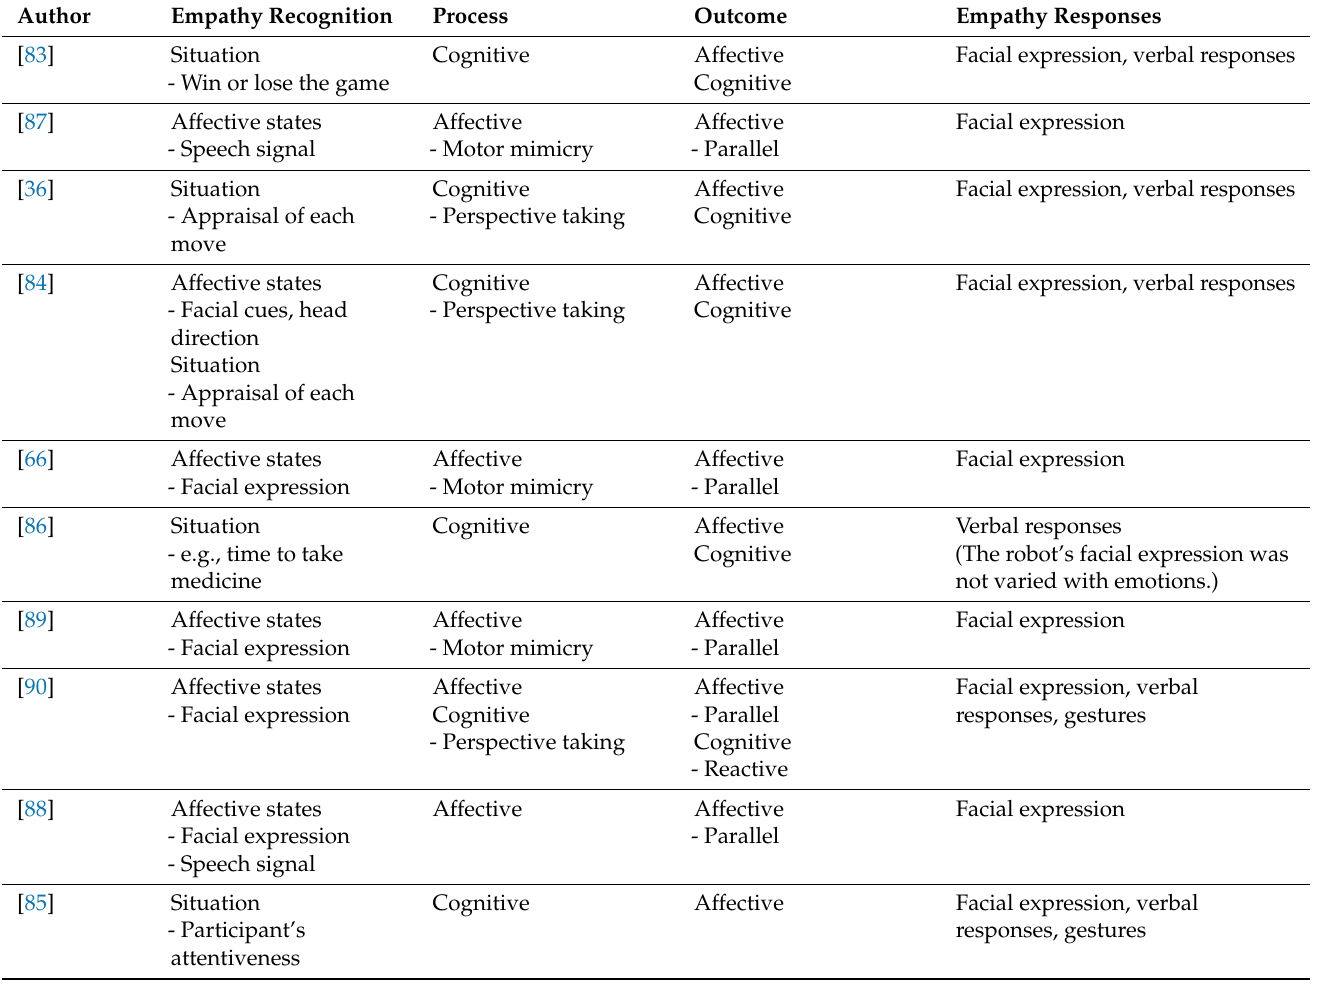
Table 6. Empathic recognition and responses in social robot